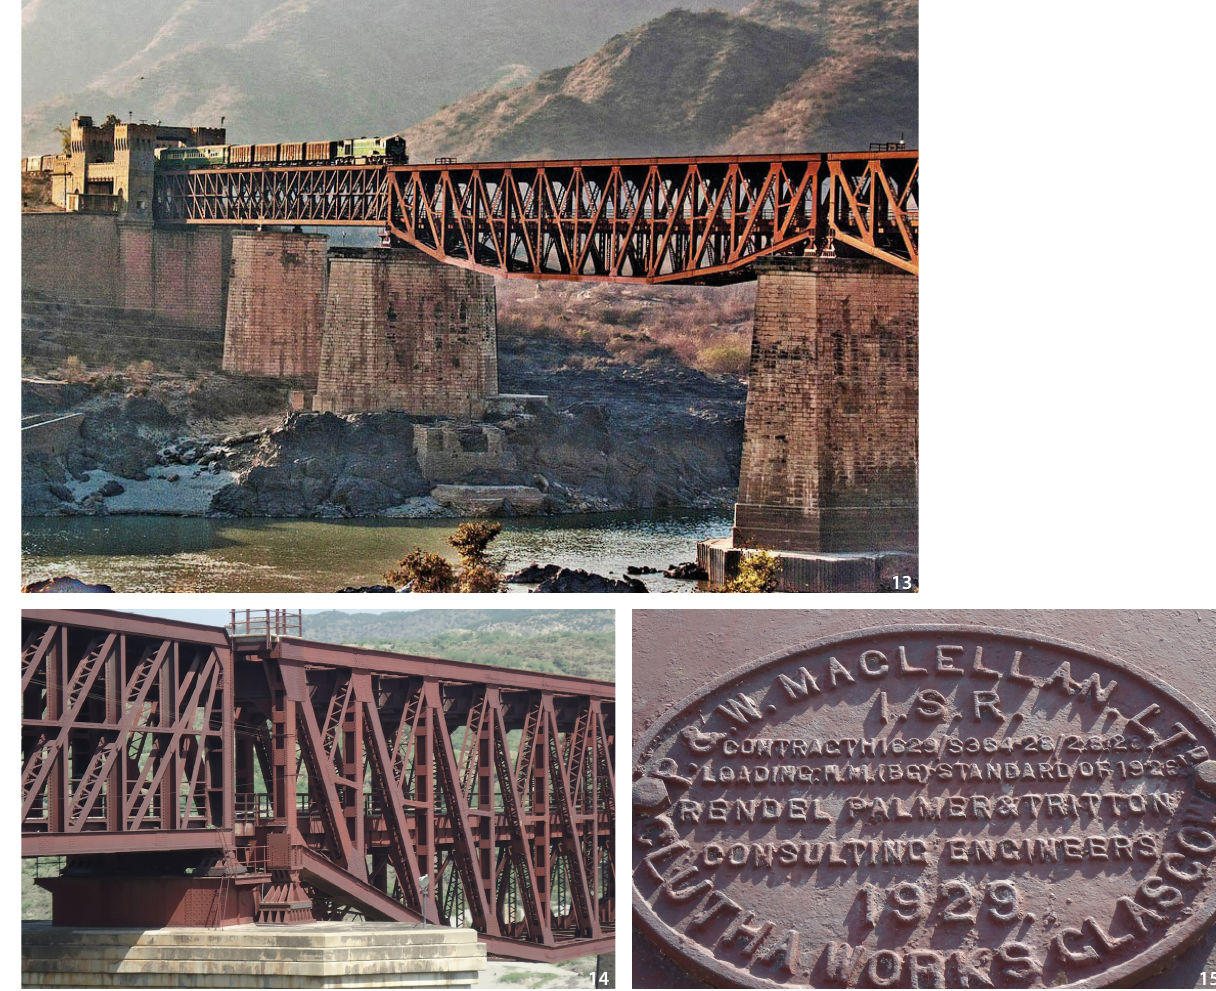
Figure 13 Attock Bridge in its setting on the Indus River (Source: Baloch). Figure 14 Old and new fabric sections of Attock Bridge: 1880 section on left and 1929 section on right with gap visible between (Source: Baloch). Figure 15 Original plaque on Empress Bridge that documents the date and place of manufacture and the engineers (Source: